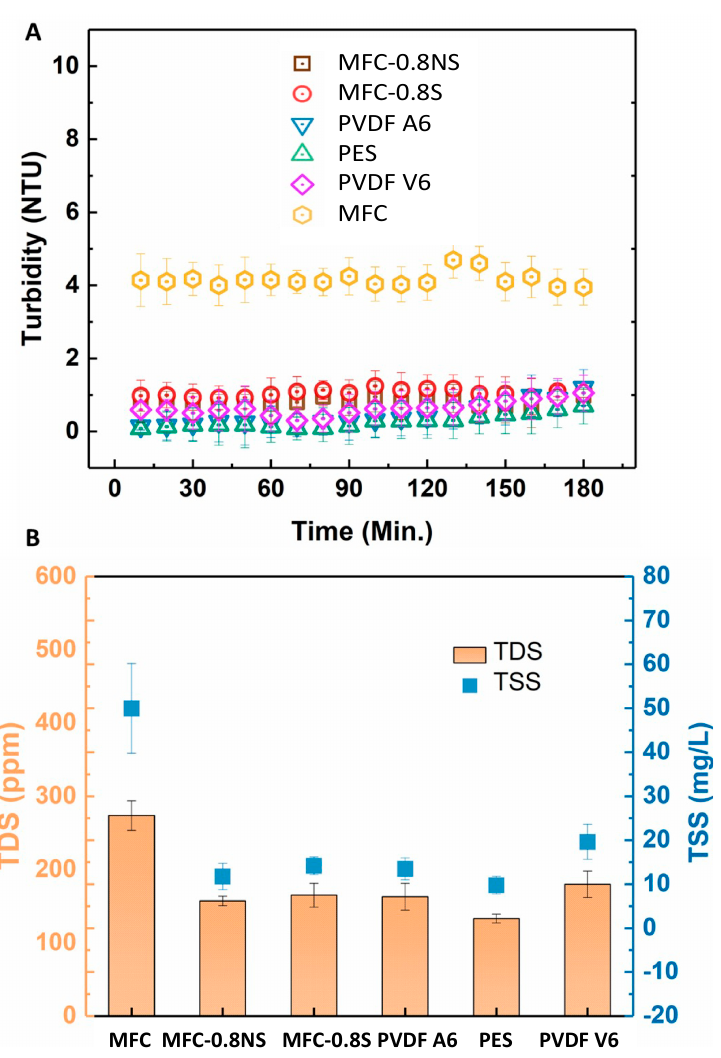
Figure 11. ( A ) Turbidity rejection and ( B ) total dissolved solids and total suspended solids rejection efficiency of MFC-based and commercial membranes.